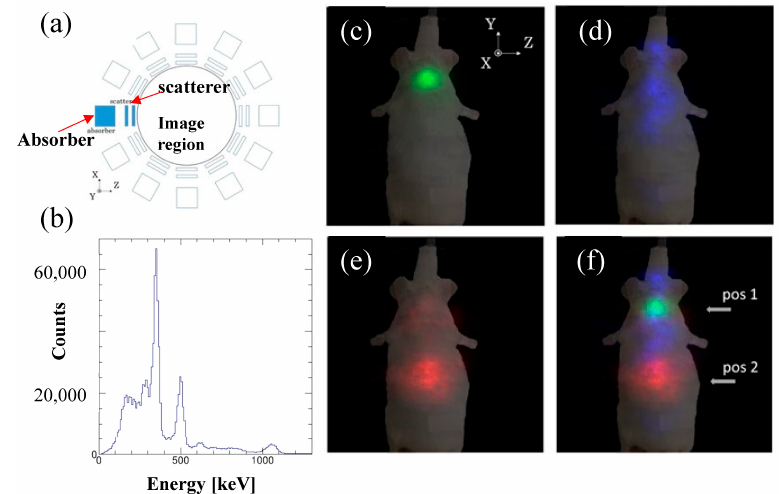
Figure 10. ( a ) Configuration of multi-angle data acquisition measurement of Ce:GAGG Compton camera. ( b ) Energy spectrum obtained via 10-min measurements from an angle in a mouse injected with 131 I, 85 Sr, and 65 Zn. ( c ) Compton image of 131 I, ( d ) 85 Sr, and ( e ) 65 Zn, and ( f ) fused images of all three tracers. All the figures are reprinted from Kishimoto et al. [155]. Reproduced with permissions from Kishimoto et al. [155].